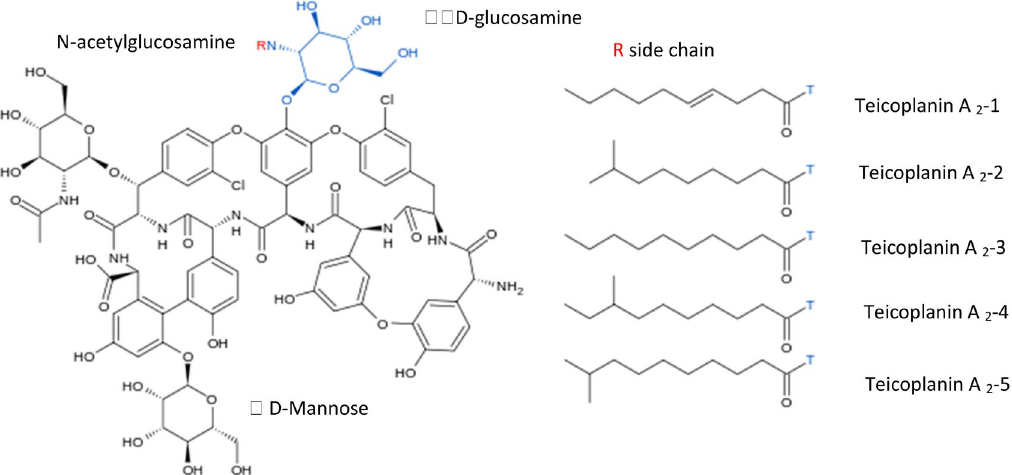
Figure 1. Structure of